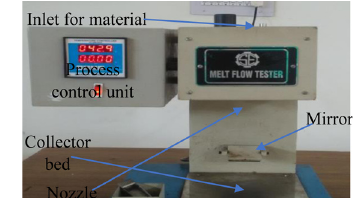
Figure 2. Schematic